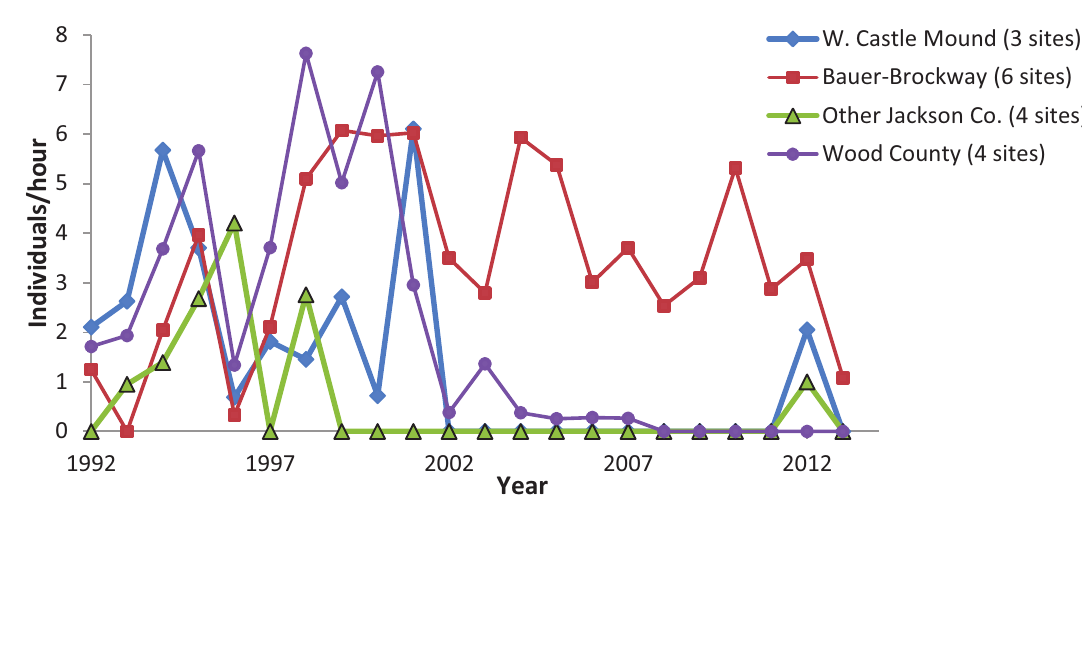
Figure 8. Mean C. irus abundance, by geographical